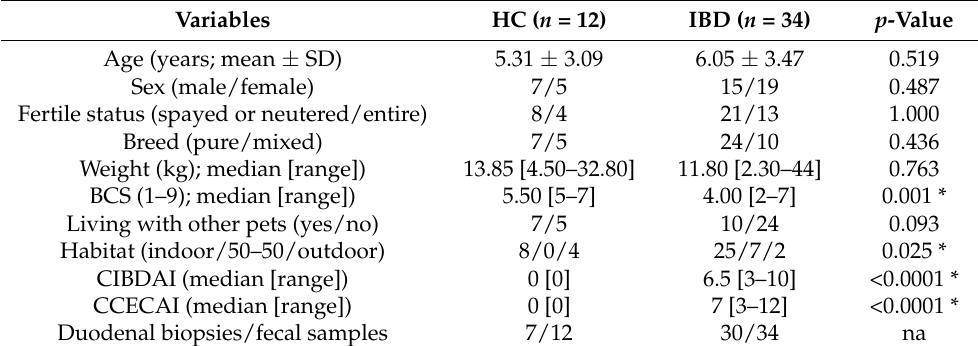
Table 1. Comparison of signalment, epidemiological data, and clinical scores of the dogs enrolled in the study.